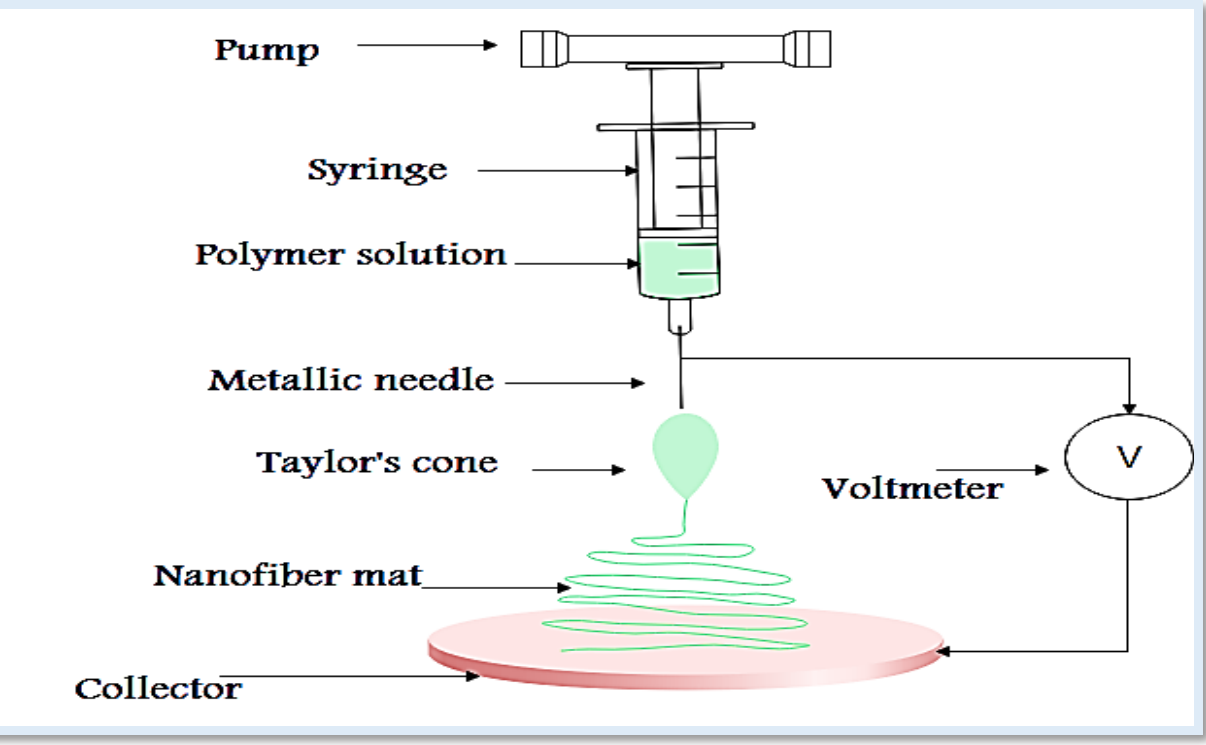
Figure 2. Schematic diagram of electrospinning process .